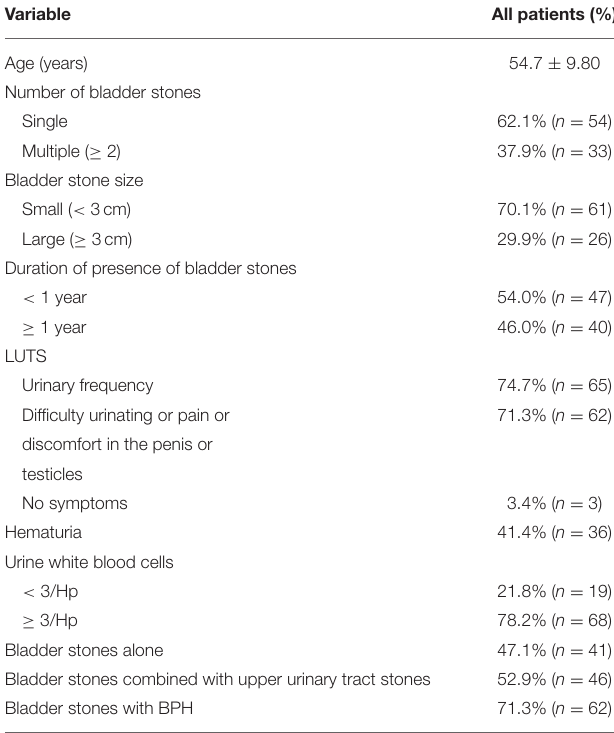
TABLE 1 | Clinical characteristics of the study